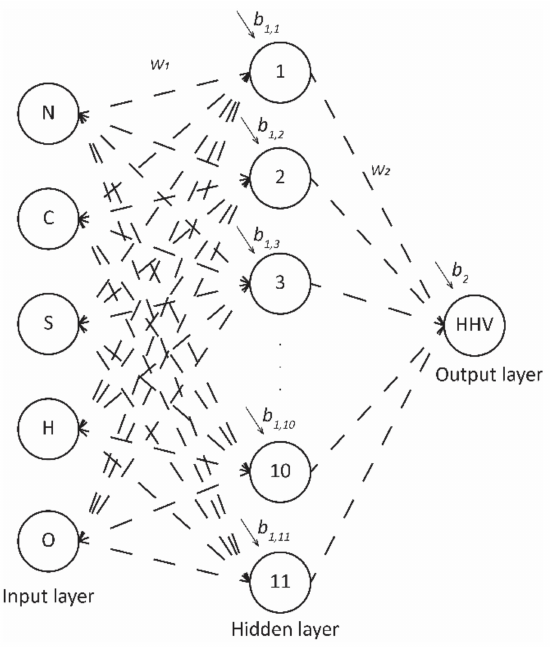
Figure 1. Structure of 5-11-1